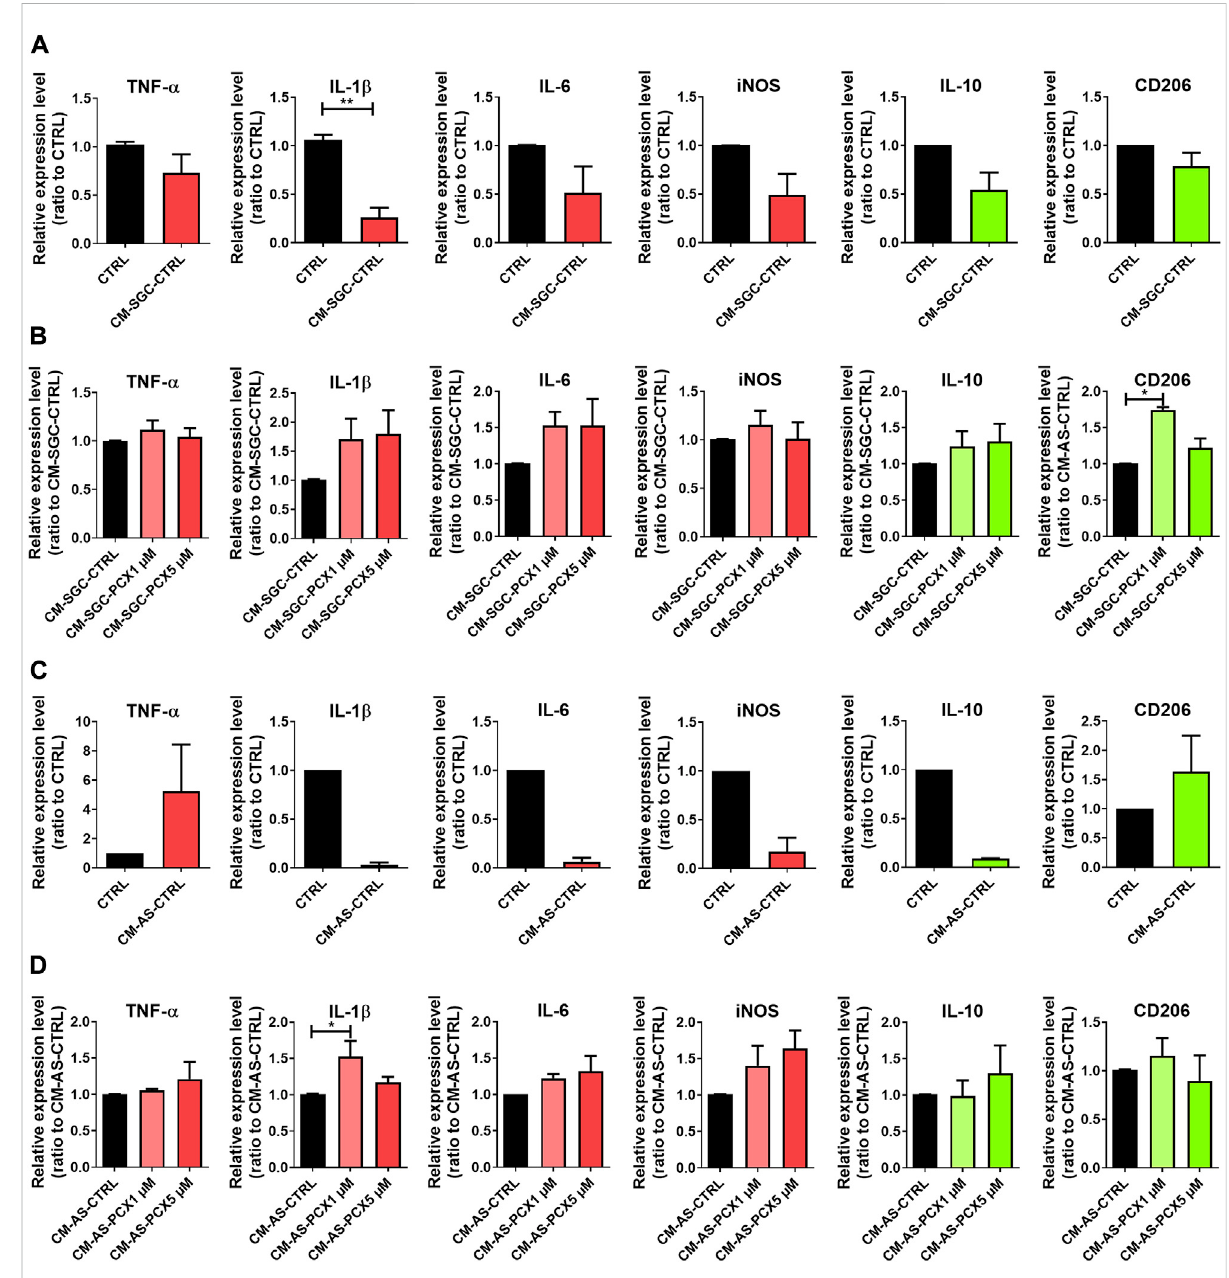
FIGURE 5 Effects of paclitaxel-exposed astrocytes and – satellite glial cells (SGCs) on microglia. SGC and astrocytes were exposed to 1 μ M or 5 μ M paclitaxel or received no paclitaxel for 24 h, before themedium was exchanged, and cells werecultured for further 24 h. For an easier interpretation of the data, pro-in fl ammatory markers are depicted in red, anti-in fl ammatory markers are depicted in green. (A) Microglia were exposed to the control secretome (CM-SGC-CTRL) of SGC and relative expression levels in ratio to control-exposed microglia (CTRL) of tumor necrosis factor- α (TNF- α ), Interleukin-1 β (IL-1 β ), IL-6, iNOS, IL-10 and cluster of differenetiation 206 (CD206) were assessed ( n (number of independent cell culturepreparations)=3). (B) Microgliawereexposedtocontrolsecretome(CM-SGC-CTRL),1 μ Mexposedsecretome(CM-SGC-PCX1 μ M)or5 μ M exposedsecretome(CM-SGC-PCX5 μ M)ofSGC,andexpressionlevelsinratiotoCM-SGC-CTRLofTNF- α ,IL-1 β ,IL-6,iNOS,IL-10andCD206were assessed ( n (number of independent cell culture preparations) = 3). (C) Microglia cells were exposed to the control secretome (CM-AS-CTRL) of astrocytes, and relative expression levels in ratio to unexposed microglia (CTRL) of TNF- α , IL-1 β , IL-6, iNOS, IL-10 and CD206 were assessed ( n (number of independent cell culture preparations) = 2). (D) Microglia were exposed to the control secretome (CM-AS-CTRL), 1 μ M exposed secretome(CM-AS-PCX1 μ M),or5 μ Mexposedsecretome(CM-AS-PCX5 μ M)astrocytesandexpressionlevelsinratiotoCM-AS-CTRLofTNF- α ,IL- 1 β ,IL-6,iNOS,IL-10andCD206wereassessed( n (numberofindependentcellculturepreparations)=3).Graphsdepictmean±standarderrorofthe mean (SEM). Statistical comparison was performed between all groups (Two groups: Mann-Whitney-U-test; multiple groups: Kruskal-Wallis test, Dunn ’ s multiple comparison test); * p < 0.05, ** p <